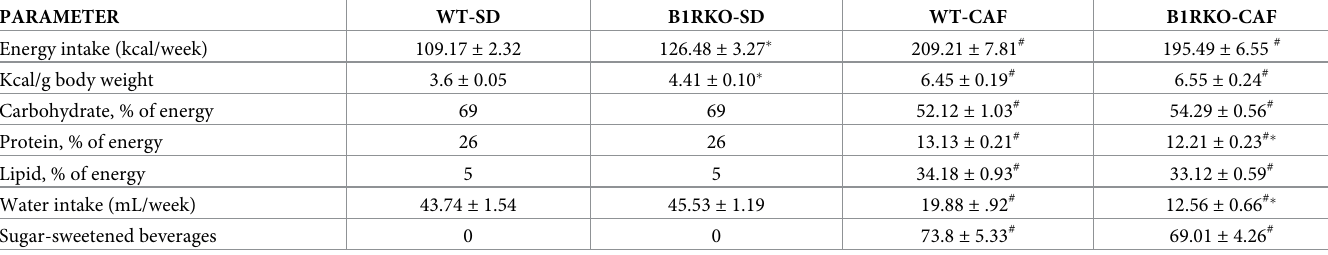
Data are expressed as mean ± SEM of the weekly values obtained from each box divided by the number of animals living in the box. In the CAF diet, foods were given in natura , and the macronutrient intake thus varied each week. P-values by one-way ANOVA followed by the Bonferroni post-hoc test. Statistical comparison between WT x B1RKO in the same diet ( � ) or SD x CAF in the same genotype. (#) indicates p <